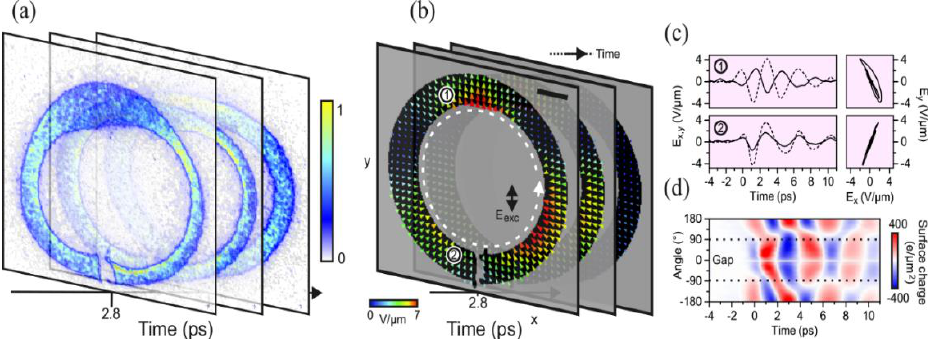
Fig. 3 . Transmission electron microscopy of electromagnetic waveforms. (a) Subset of raw shadow images. (b) Time-dependent fields. (c) Polarizations at locations (1) and (2) in (b). (d) Space-time map of the surface carrier density at the inner edge; dashed line in (b).